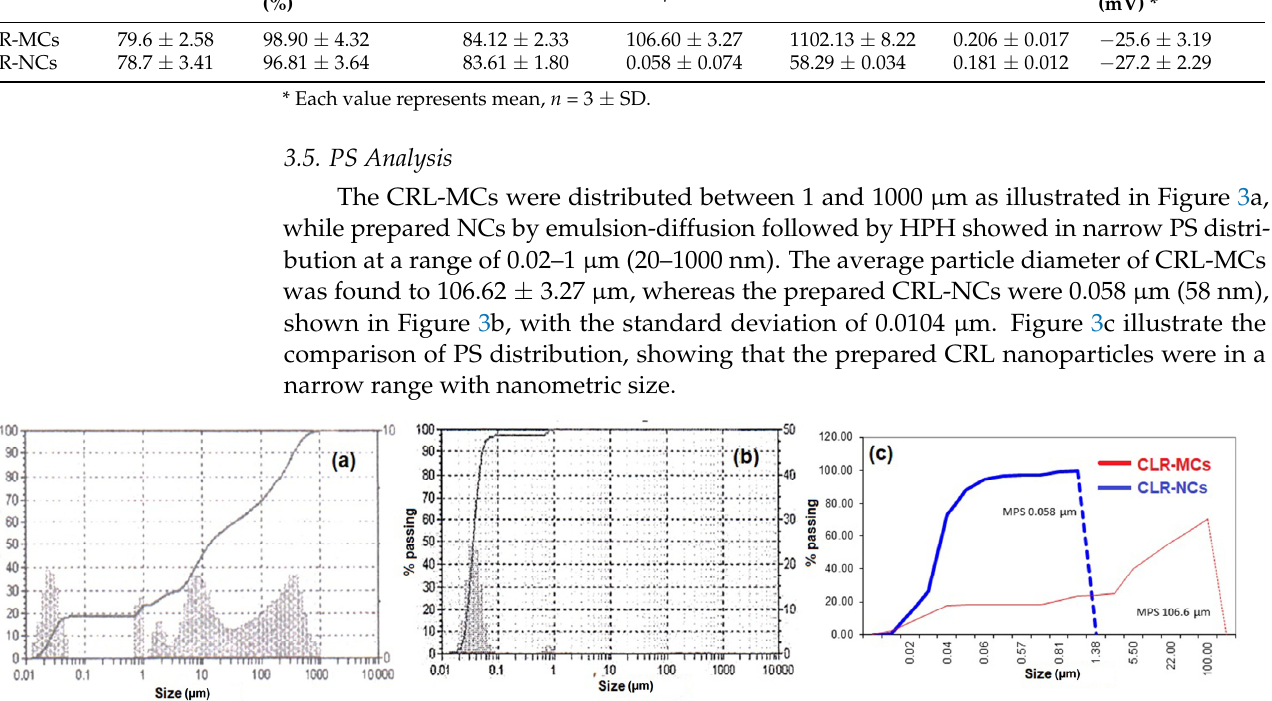
Figure 4. ( a ) PS and PDI, ( b ) ZP of CRL − NCs . This size of the CRL-NC particle had a large interfacial surface area, which helps with drug absorption and lymphatic transit [18]. PDI value less than 0.5 are considered usual for nanocrystals. Because the surfactant monolayer for nanostructures has a very low in- terfacial tension, there is less of a consequence (more chance) for having a non-spherical shape, compared to normal emulsions, which typically have spherical structures due to high interfacial tensions favouring globule interfacial area reduction (the sphere has the lowest interfacial area for a given volume). 3.7. SEM The SEM photographs for CRL-MC and NCs are shown in Figure 5, which shows the distinct difference in the morphology of samples. In the SEM of the CRL-MCs, the bound- ary and core of well-identified spherical formations can be observed. The prepared CRL- NCs were nearly spherical in shape, the surface of a particle was smooth and the PS in nanometric range (Figure 5b), whereas CRL-MCs were predominantly needle shape crys- tals with a lighter exposed core, surrounded by a denser boundary that perfectly ringed the centre (Figure 5a). When a thin polymer layer is hydrated, it forms an encircled crystal network, allowing the system to change shape from globular to spherical and attain ther- modynamic stability by reducing total free energy [27]. Even after applying diverse me- chanical stressors, such as sonication and HPH, the spherical structure’s stability was proven.